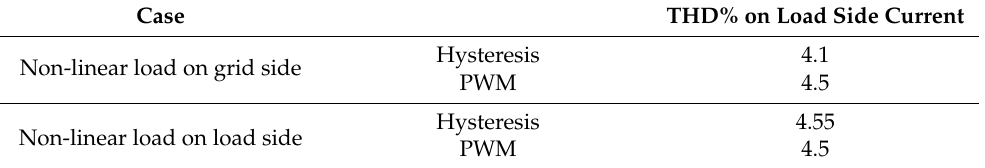
Table 4. Results compression for current THD.